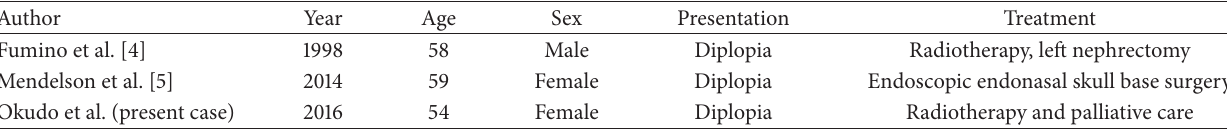
Table 1: Cases of clivus metastasis specifically from RCC.